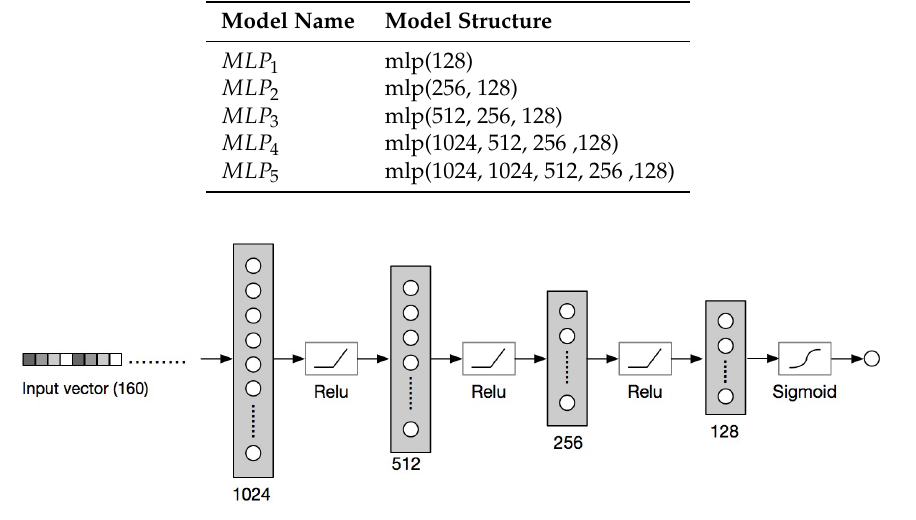
Figure 5. The architecture of multi layer perceptron (MLP) 4